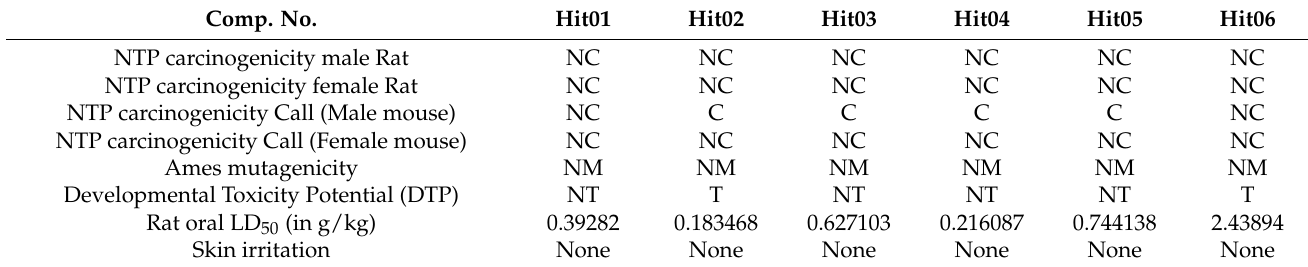
Table 5. Toxicity Predictions of the lead molecules by